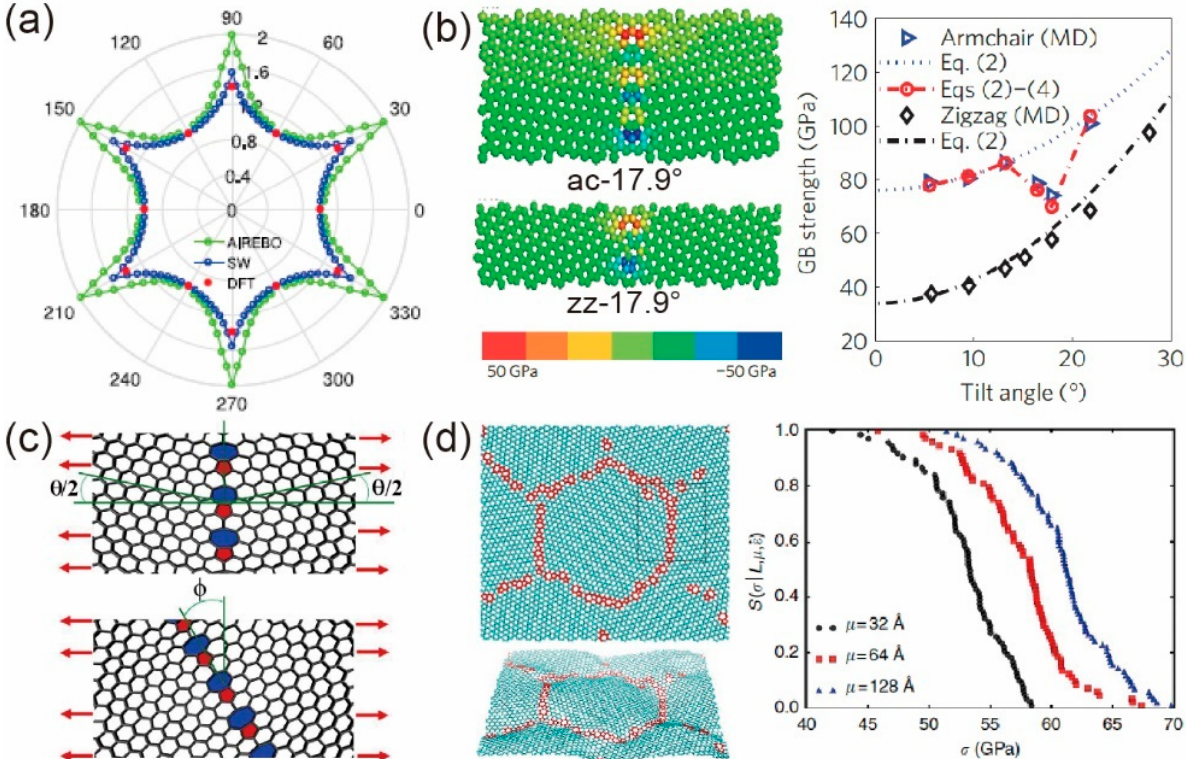
Figure 2. In-plane mechanical behaviors of monolayer graphene. ( a ) Anisotropic toughness of pristine graphene. Reprinted with permission from [66]. ( b ) Initial stress field induced by grain boundaries with different tilt angles along armchair (ac) and zigzag (zz) directions, and the strength-tilt angle relation. Adapted and reprinted with permission from [67]. ( c ) Schematic plot of two grains showing GB tilt angle ( θ ) and tensile loading angle ( ϕ ). Reprinted with permission from [68]. ( d ) Top and perspective views of graphene polycrystalline, and the survival probability predicted by the statistic model. Reprinted with permission from [69]. Table 1. The Young’s modulus and Cauchy ultimate strength of defect ‐ free graphene obtained from different methods. Method